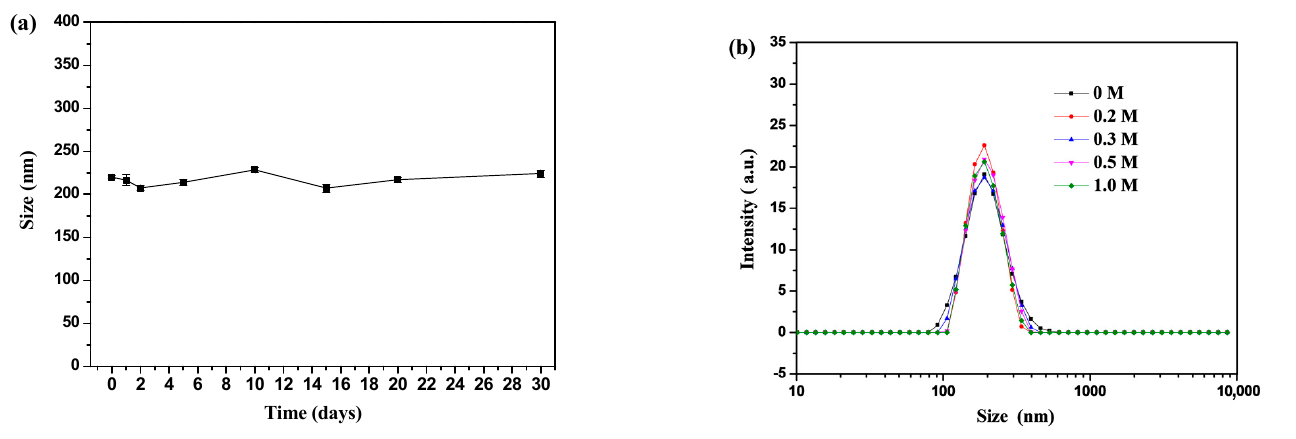
Figure 4. Stability of PSBMA-4 nanogels. ( a ) Changes in particle sizes in water for a month at room temperature. ( b ) The size distributions in different concentrations of aqueous NaCl solution after 24 h incubation at 37 °C.